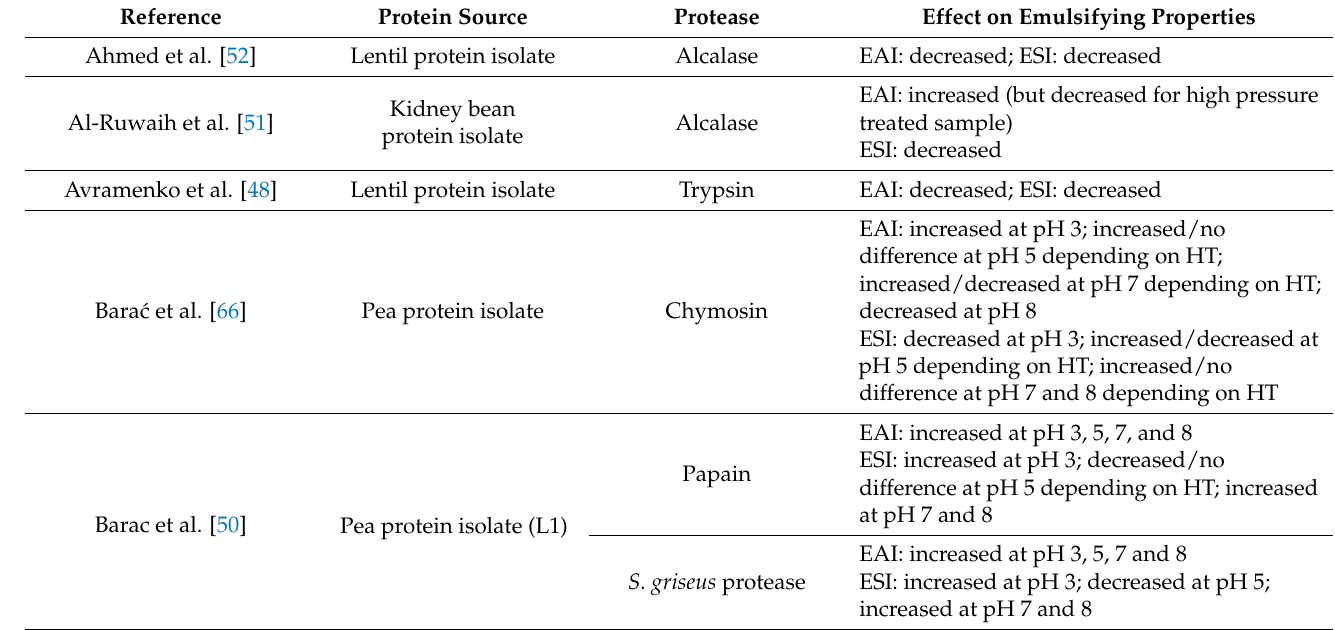
Table 3. Overview of the effects of enzymatic hydrolysis on emulsifying properties from various protein sources and